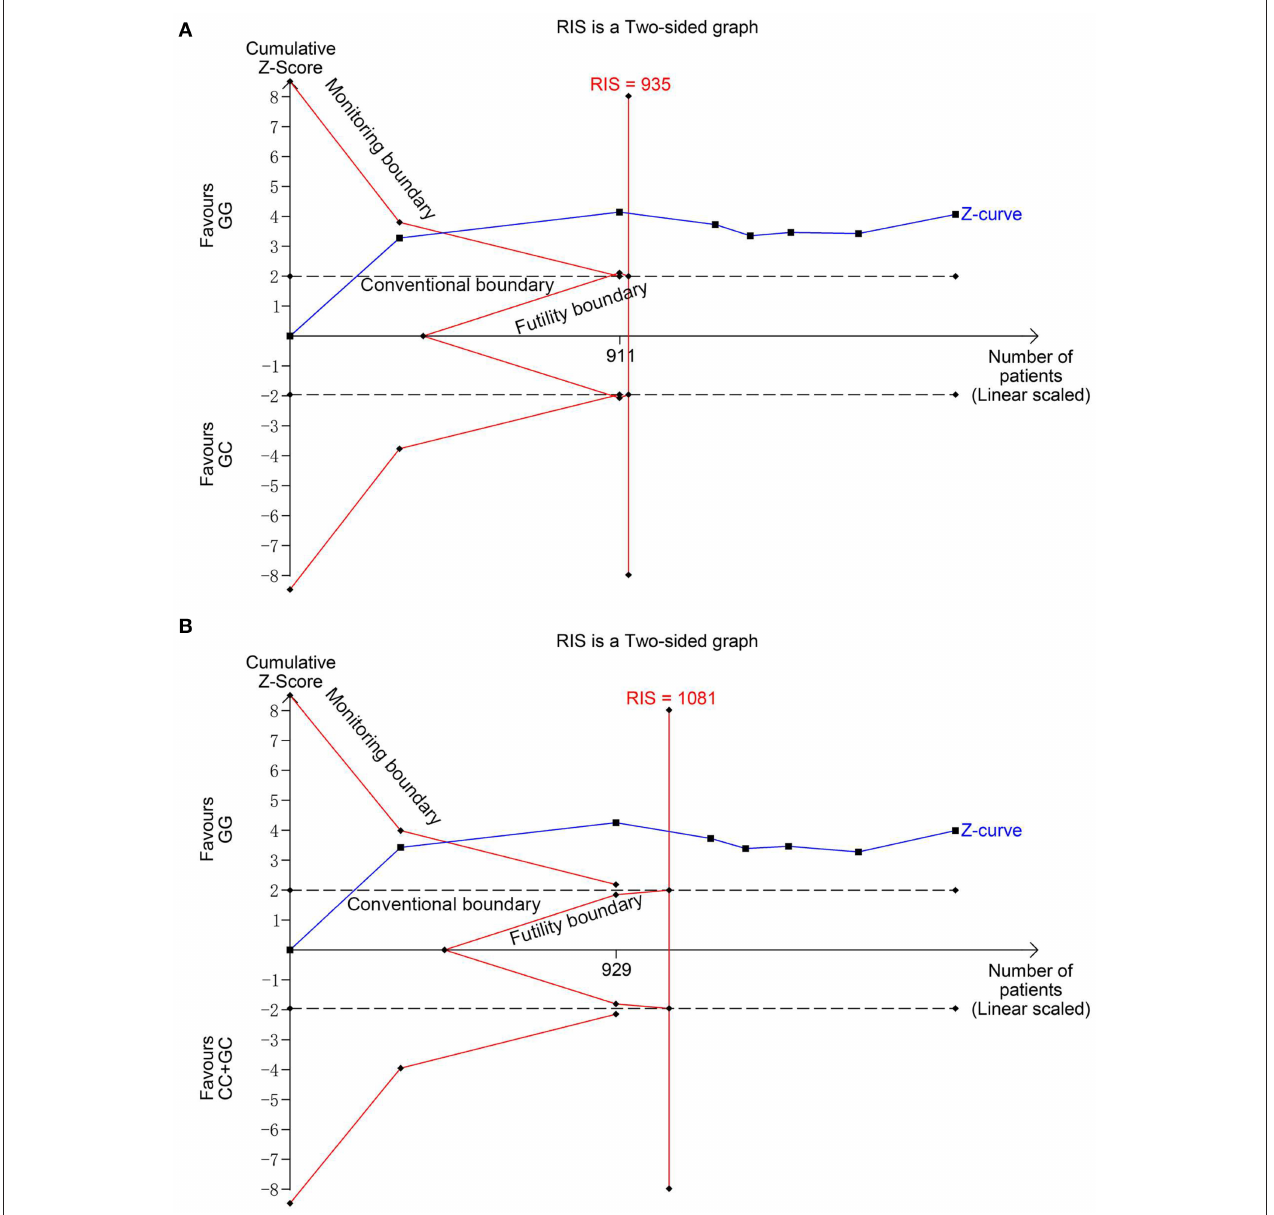
FIGURE 3 | Trial sequential analysis for the association between MIF -173G > C polymorphism and INS susceptibility under the heterozygous (A) and dominant (B) models. The required information size (RIS) was calculated based on α = 5%, 80% power, and a relative risk reduction of 20%. The cumulative Z-curves crossed the monitoring boundaries and surpassed the RIS in (A) and (B) , indicating sufficient evidence for the significant associations.